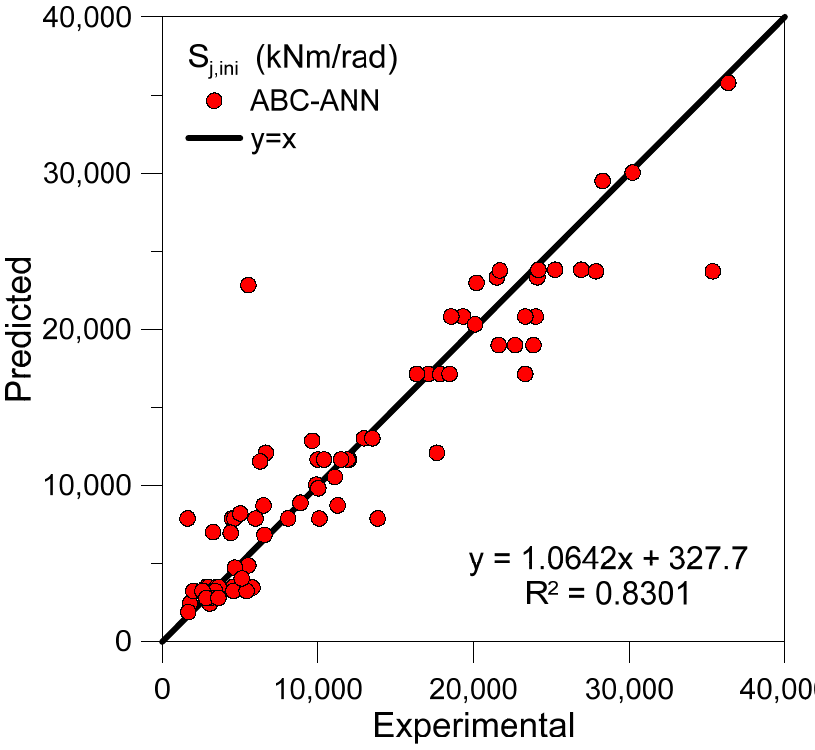
Figure 8. ABC-ANN calculated versus experimentally observed values for the parameter S j,ini .